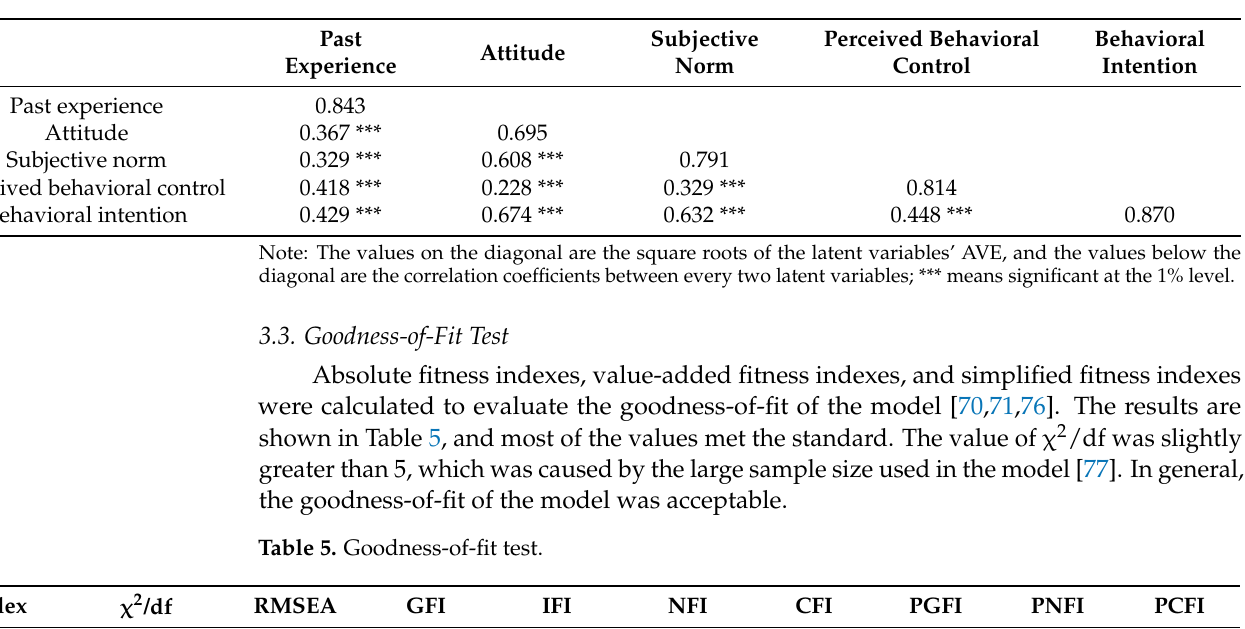
Table 4. Discriminant validity test.